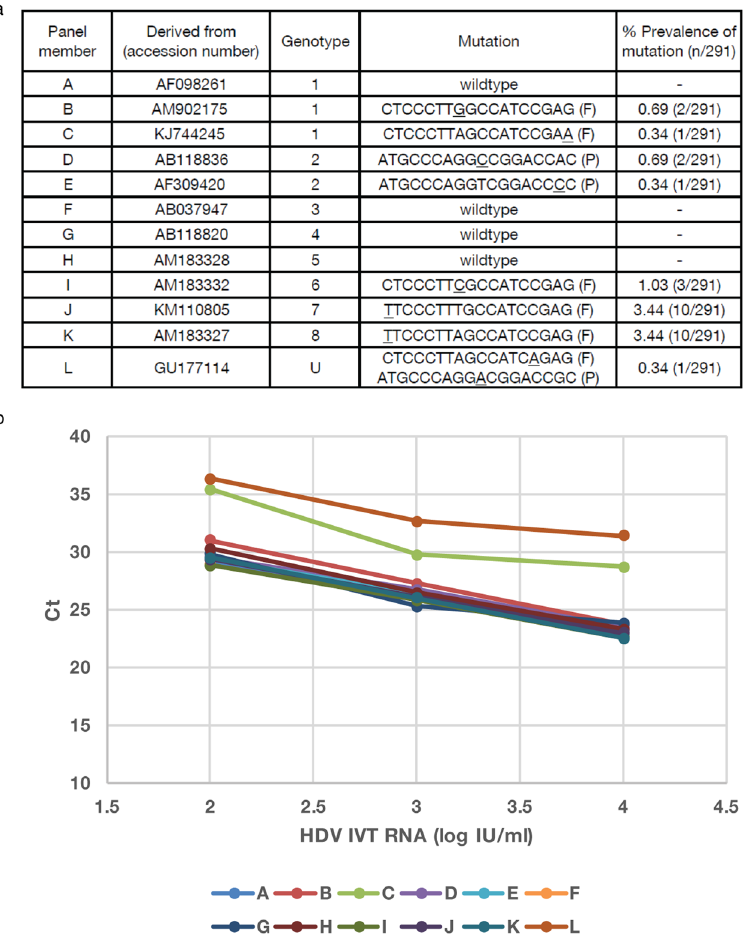
IU/ml #tested #detected %detection